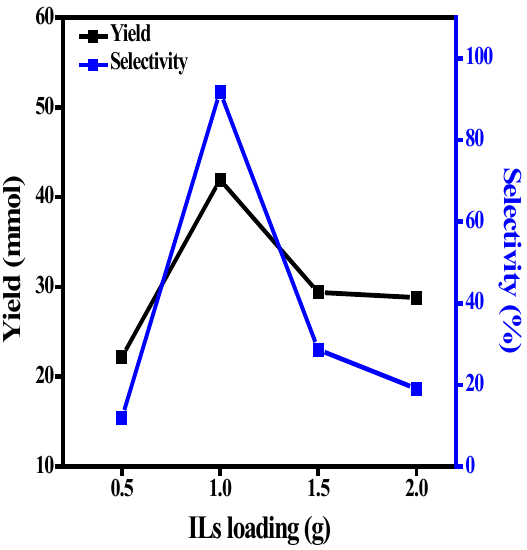
[NTf ] loading on yield and selectivity 2 2 2 pressure, 6.5 MPa, 130 ° C, 6 2